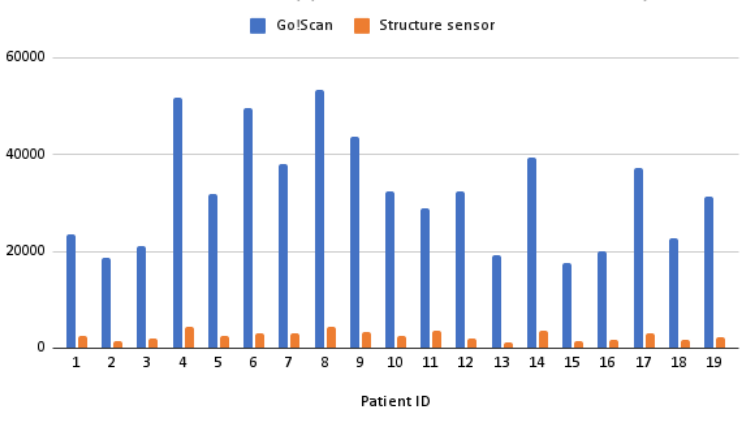
Figure 19. Bar plot of the number of faces in the cropped surfaces acquired using the two scanners.